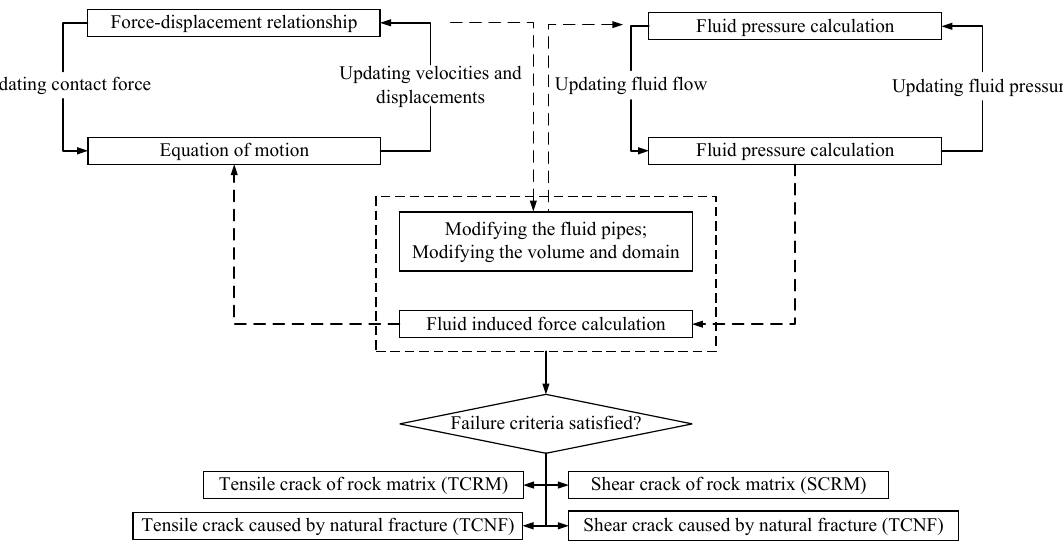
Figure 7. Modeling procedures for a hydro-mechanical coupling.